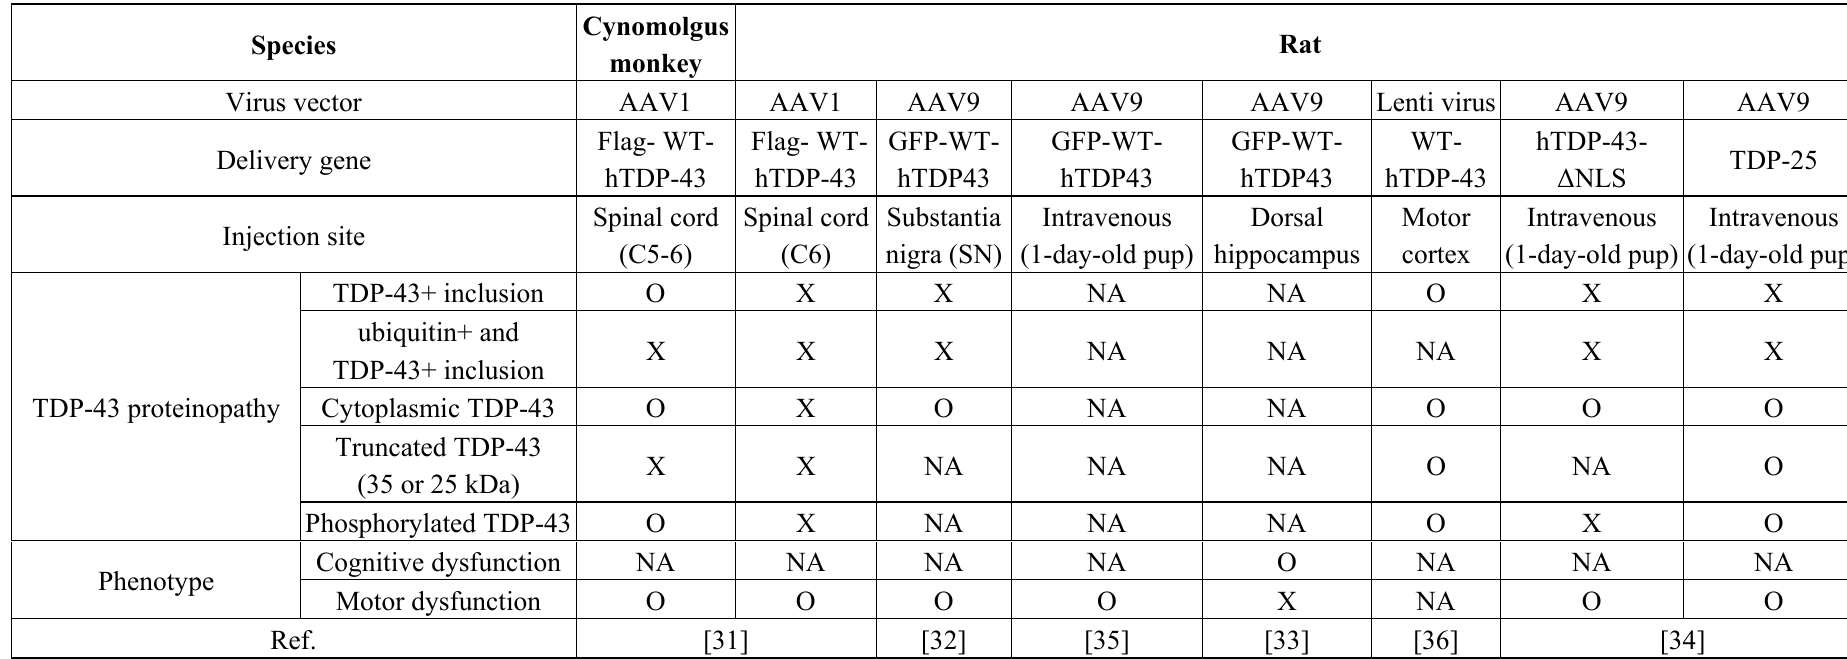
Table 2. Mammalian modes: wild-type or mutant TDP-43 overexpression by virus-induced system (NA: non-analysis). Cynomolgus Species monkey Virus vector Delivery gene